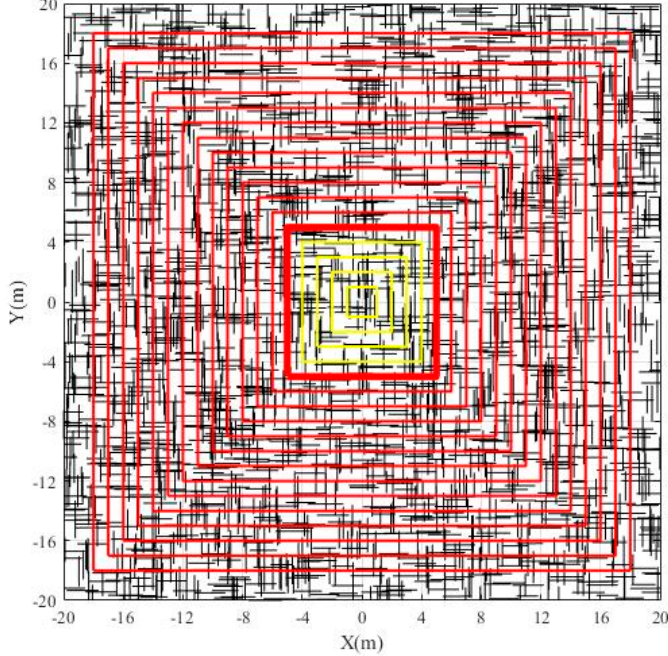
Figure 3. Fracture network and study area.